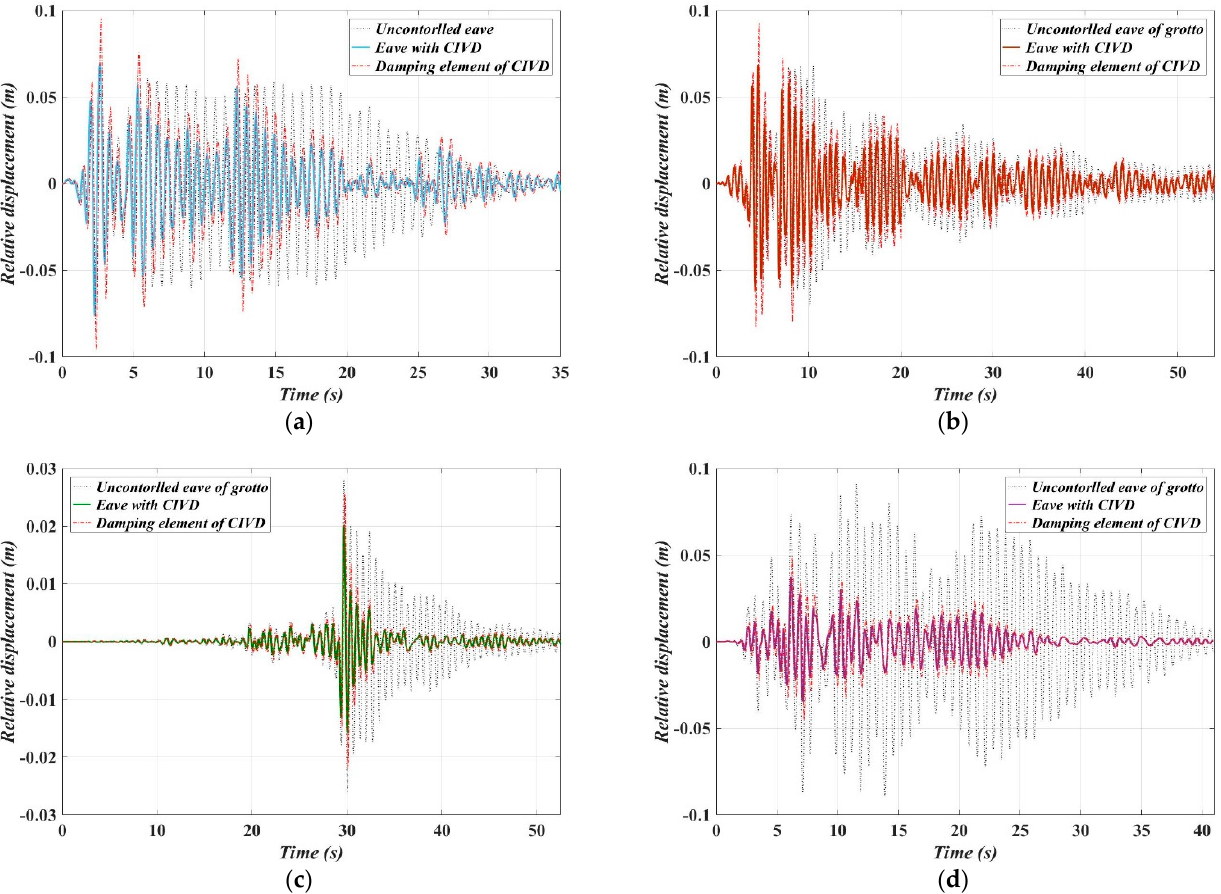
Figure 20. Displacement responses of SC eave and damping element of CIVD ( γ Ur = 0.6): ( a ) EL Centro; ( b ) Taft; ( c ) Chi-Chi; and ( d ) Kobe.